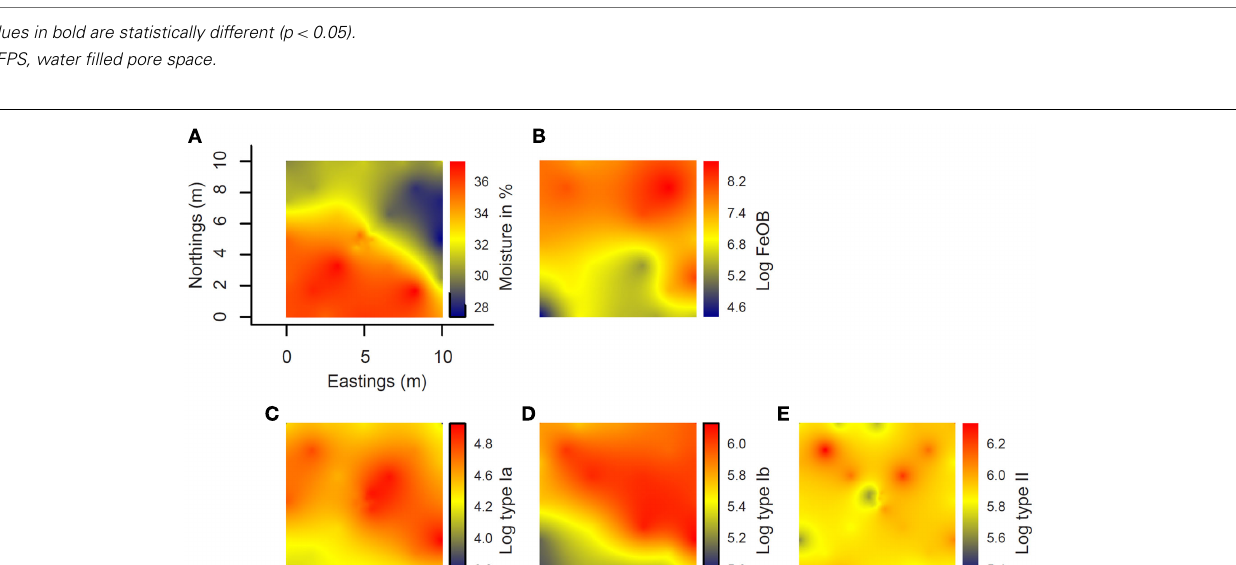
II methanotrophs specific qPCRs (E). Color bar to the right of each map indicates extrapolated values of either moisture content or log-transformed gene copy number values.